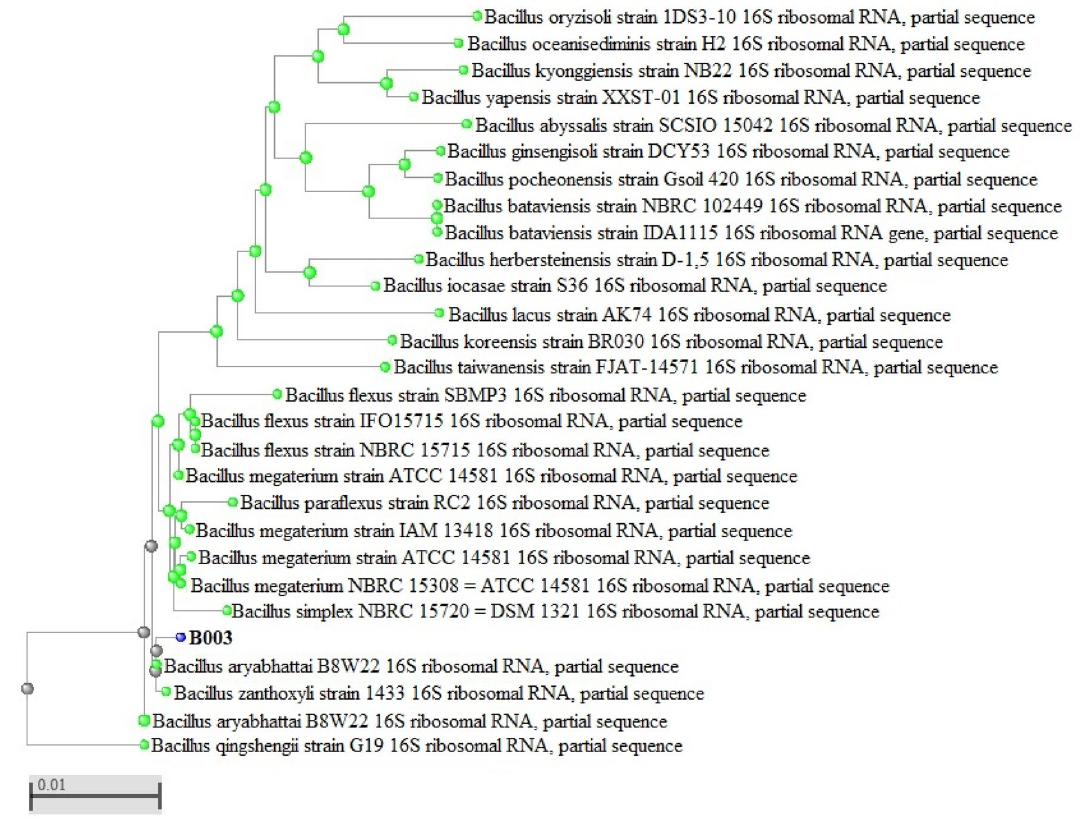
Figure 1. Phylogenetic tree of 16S rRNA sequences from the endophytic bacterium strain (B003) compared with other representative members of the Bacillus genus.